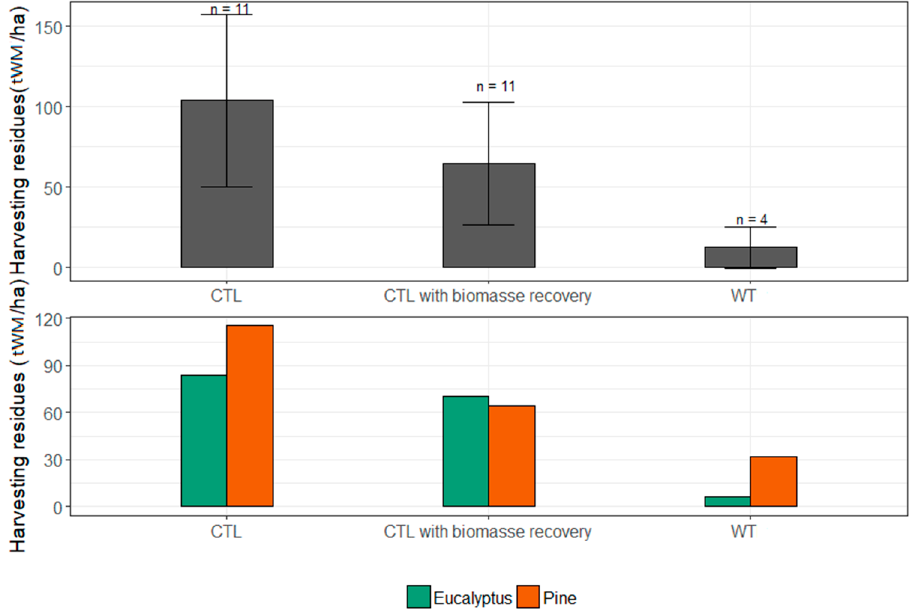
Figure 2. Average weight of harvesting residues per hectare for different harvesting methods and species. Error bars show standard species. Error bars show standard deviation. Table 3. Analysis of variance to test the impact of species.